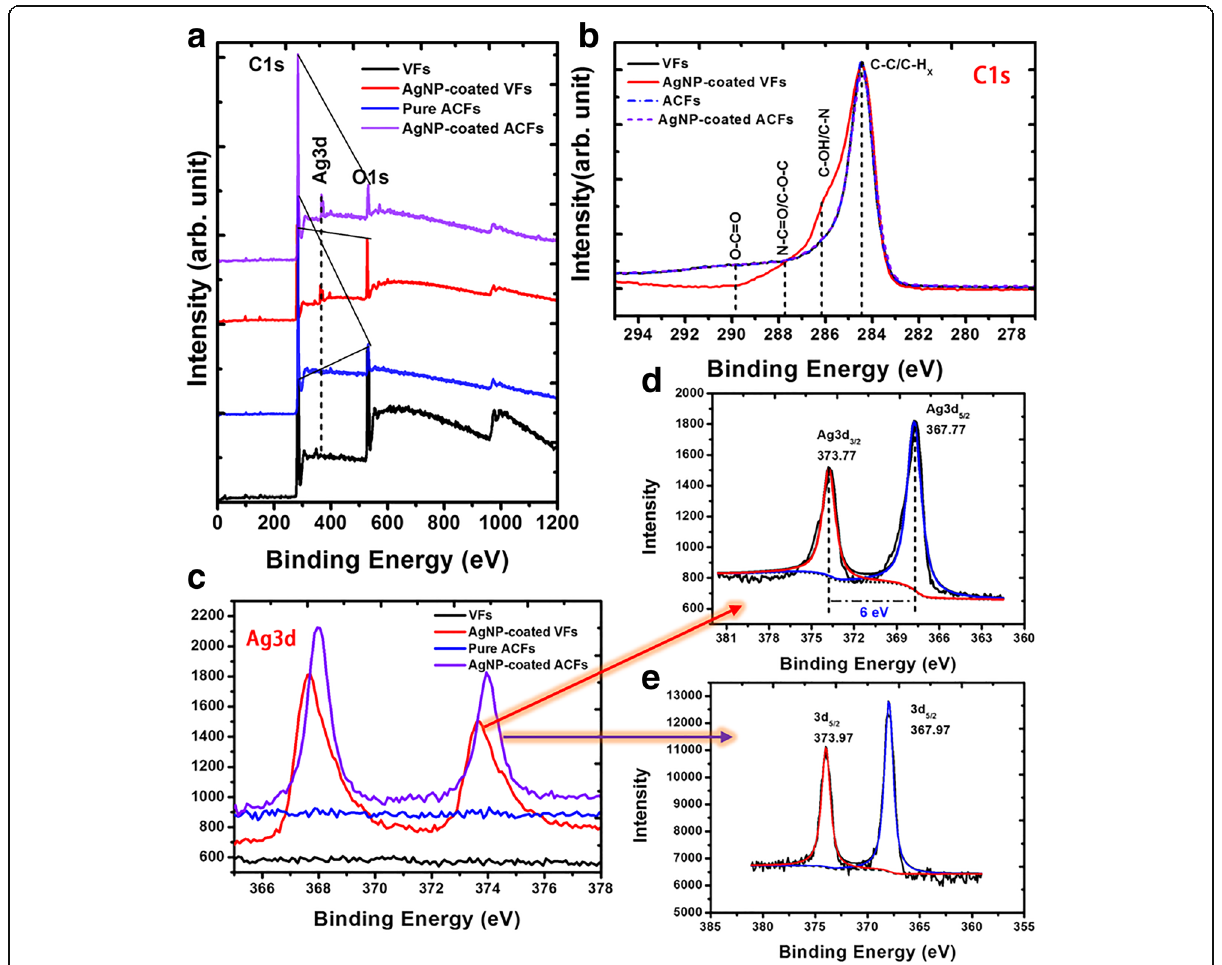
Fig. 7 XPS spectra: a wide scan, b C1s, and c Ag3d spectra of pure CFs, AgNP-coated CFs, Ag nanohair-grown ACFs, and pure ACFs. d , e are Ag3d spectra of AgNP-coated VFs ( d ) and AgNP-coated ACFs ( e